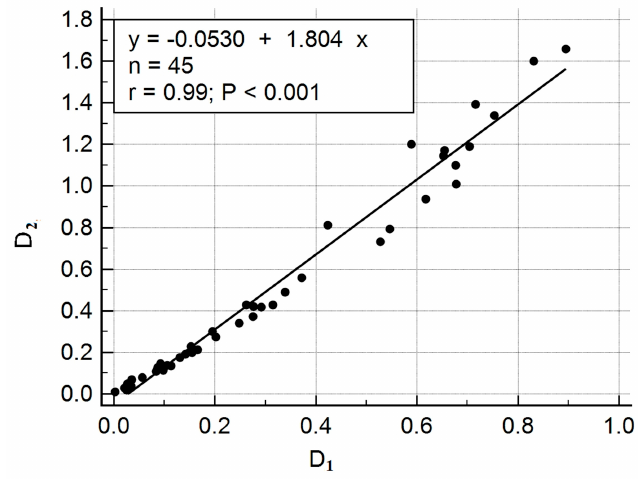
Figure 7. Comparison of the optical densities, D, obtained by two methods: D 2 –the optical densities of the samples measured using a spectrophotometer and D 1 –the optical densities of the samples measured using our experimental setup.